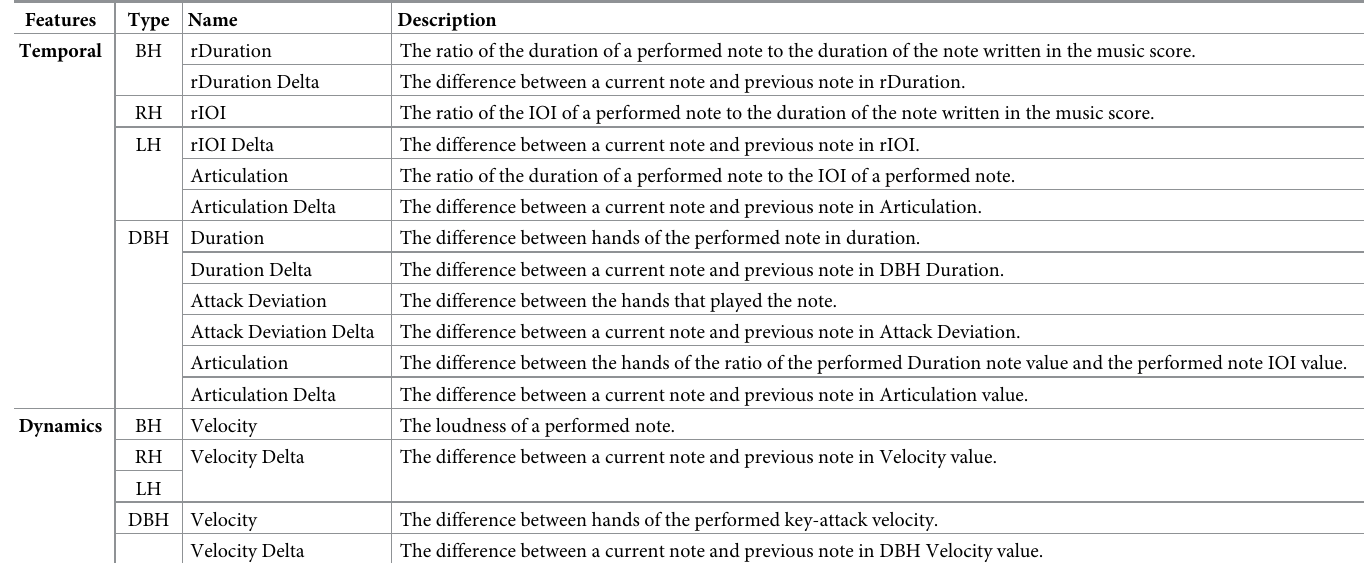
Table 1. Description of the features used for